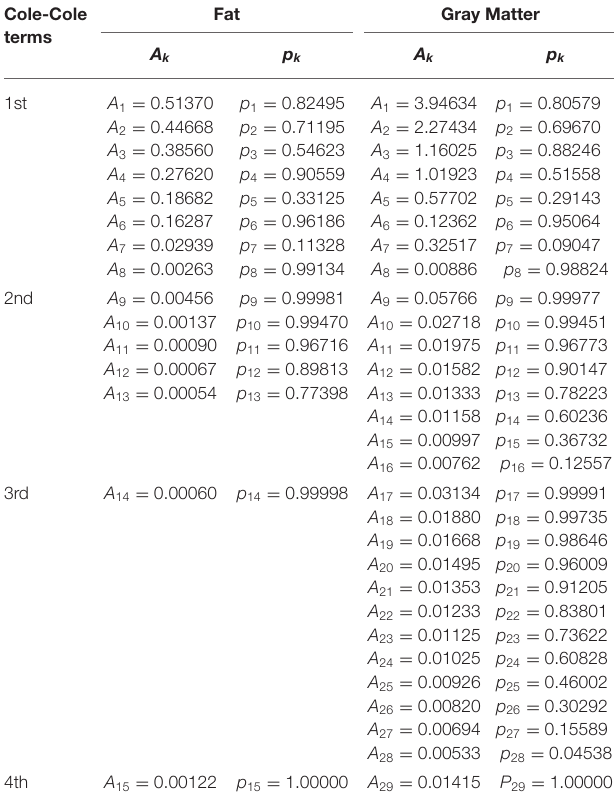
TABLE 2 | Update coefficients for “Fat” and “Gray Matter.”